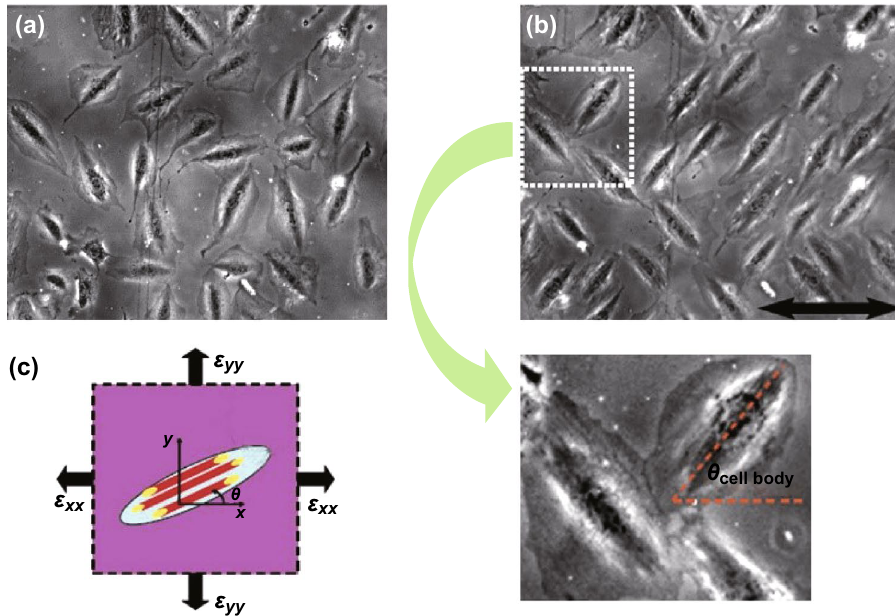
Fig. 10 Reorientation of the cells. a Cells (REF-52 fibroblast) with random orientations before stretching. b Reorientation after stretching. c The description of strain reference on a polarized cell. Adapted from Ref. [8] with